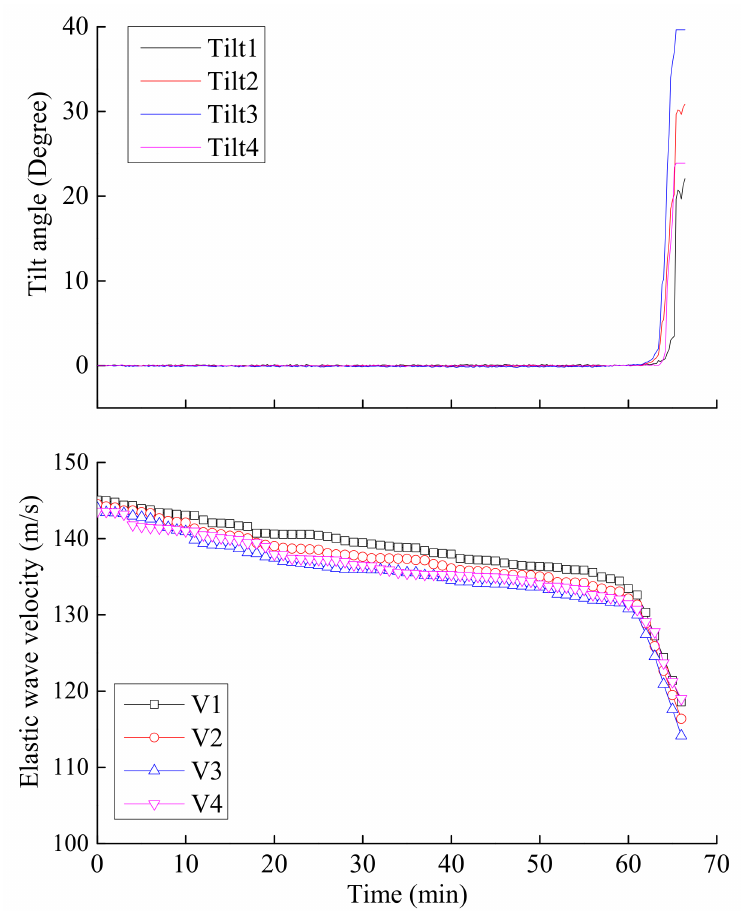
Figure 13. Time series data of tilt angle and elastic wave velocity obtained from the large-scale slope model